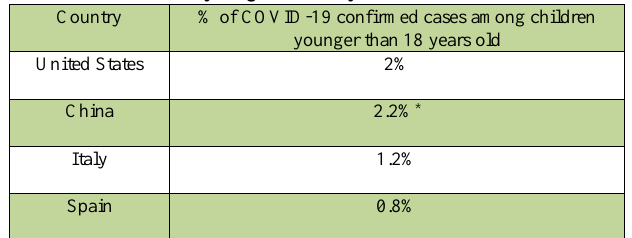
Table 1. Percentage of COVID-19 confirmed cases among children younger than 18 years